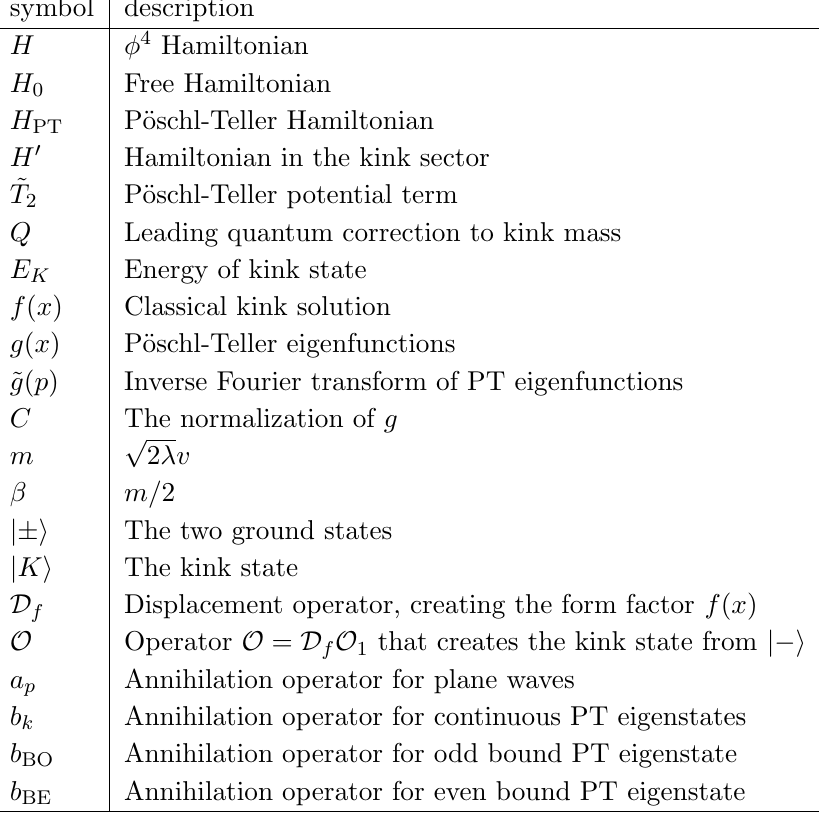
Table 1 . Summary of